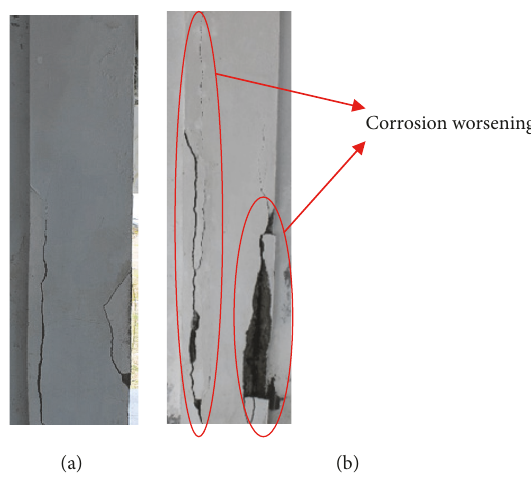
Figure 13: The visual of a column of Object II for (a) 2014 and (b) 2015.